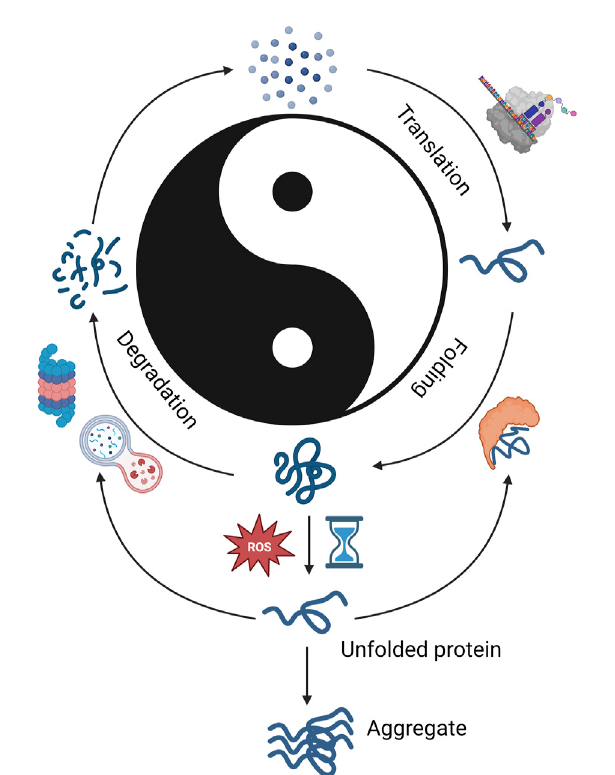
FIGURE 1 Protein lifecycle. Graphical representation of proteostatic cycle. Protein synthesis is shown on the right and protein degradation on the left. The Chinese philosophical concept Yin and Yang are denoted in the center with Yang denotating synthesis and Yin degradation. This is used to denote the importance of balance between synthesis and degradation.This fi gureshowsthatinbalancedproteostasis,proteinsare translated using the available amino acid pool (top right), folded by molecular chaperones (bottom right), degraded by proteasome or autophagial pathways (bottom left), and amino acids are recycled to form new proteins. Imbalance from insuf fi cient molecular chaperone function, ROS, or insuf fi cient degradation leads to unfolded proteins (bottom center), which may be refolded by molecular chaperones or removed by degradation pathways. If protein quality control does not occur, aggregates may form. Created with BioRender.com.